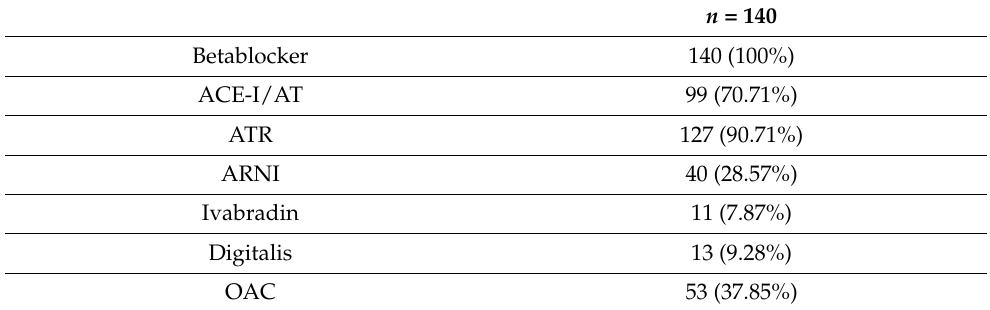
Table 2. Medication at